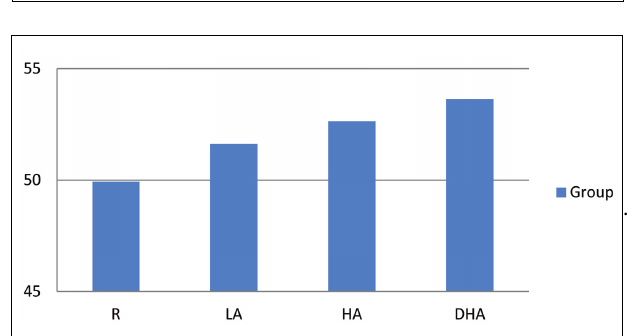
FIGURE 2 | Mean total TAS-20 scores for R, LA, HA, and DHA.